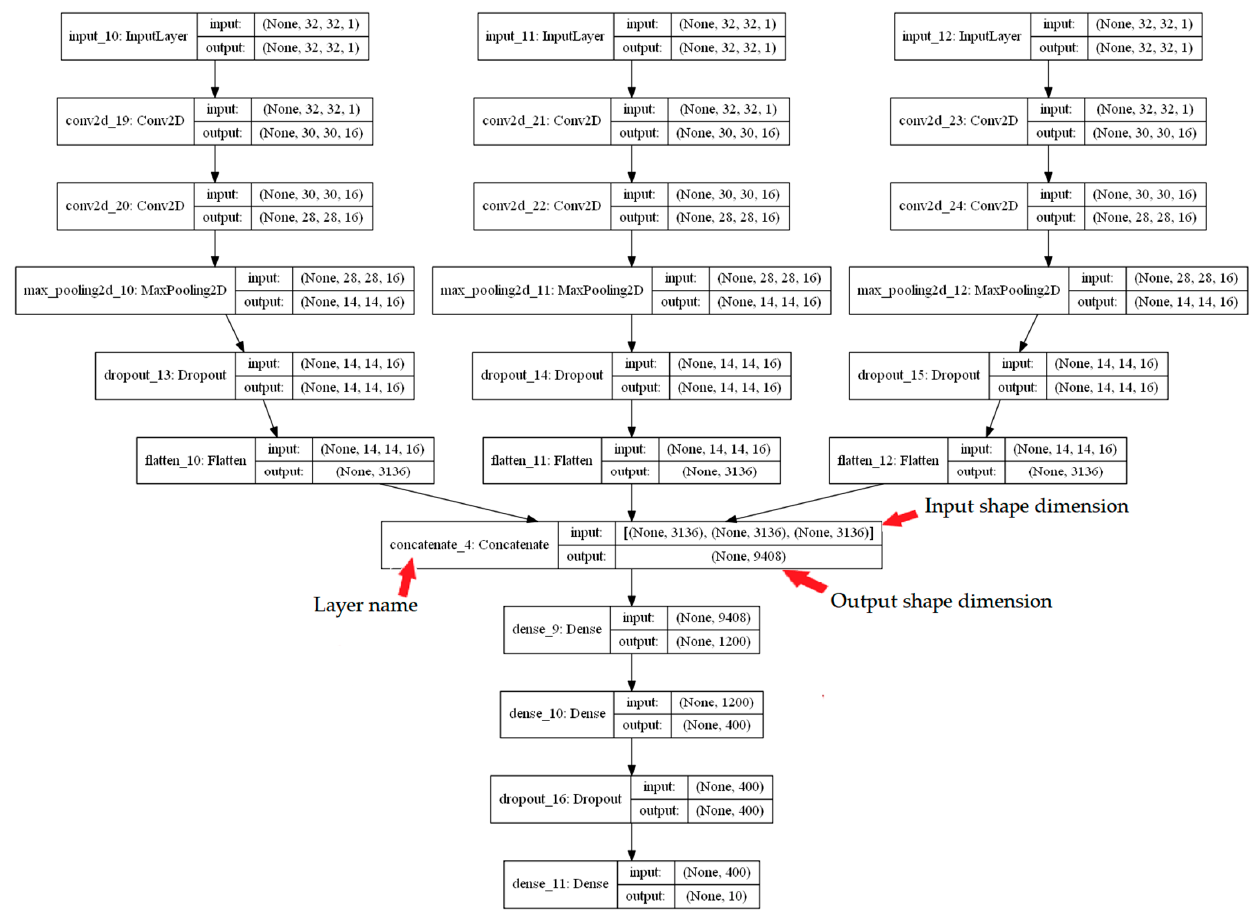
Figure 6. A CNN Model configuration for a combination case named “K” using the Mol2mat representation.